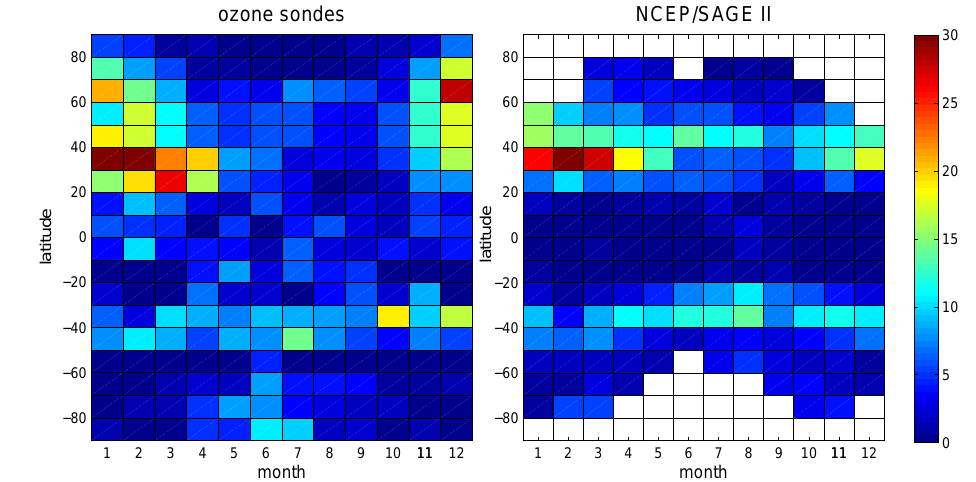
Fig. 3. Percentage of double-tropopause occurrence in ozonesonde profiles and in the NCEP/SAGE II data.